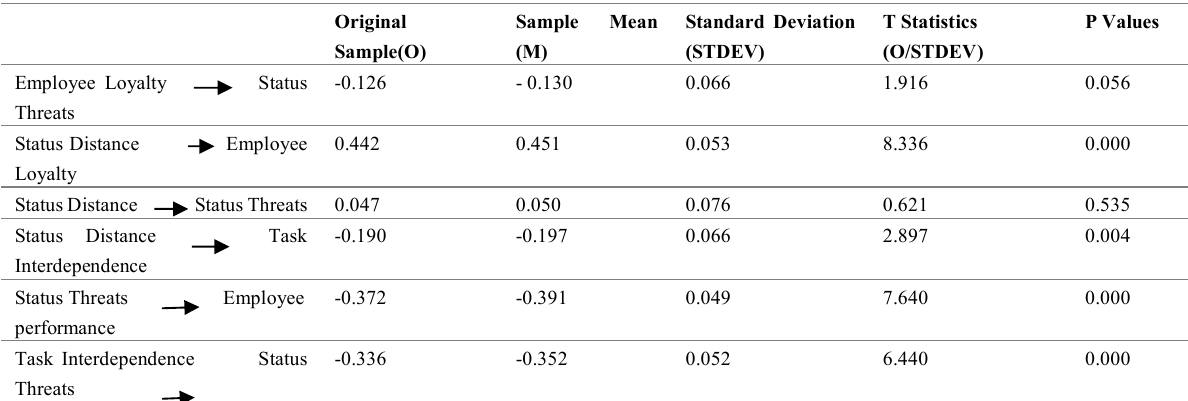
Table 2: Path coefficient